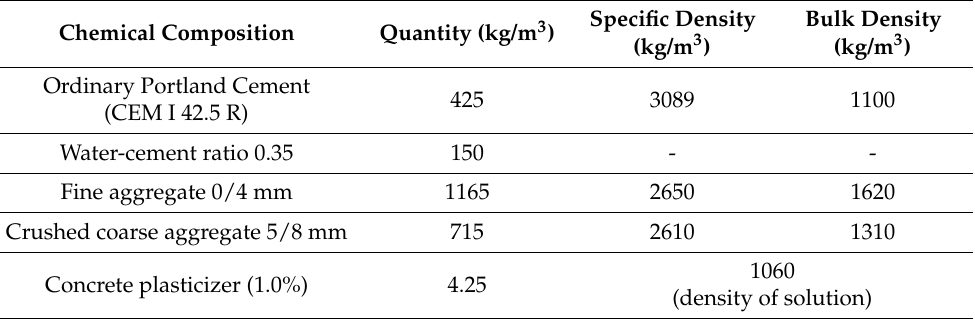
Table 1. Material Compositions.